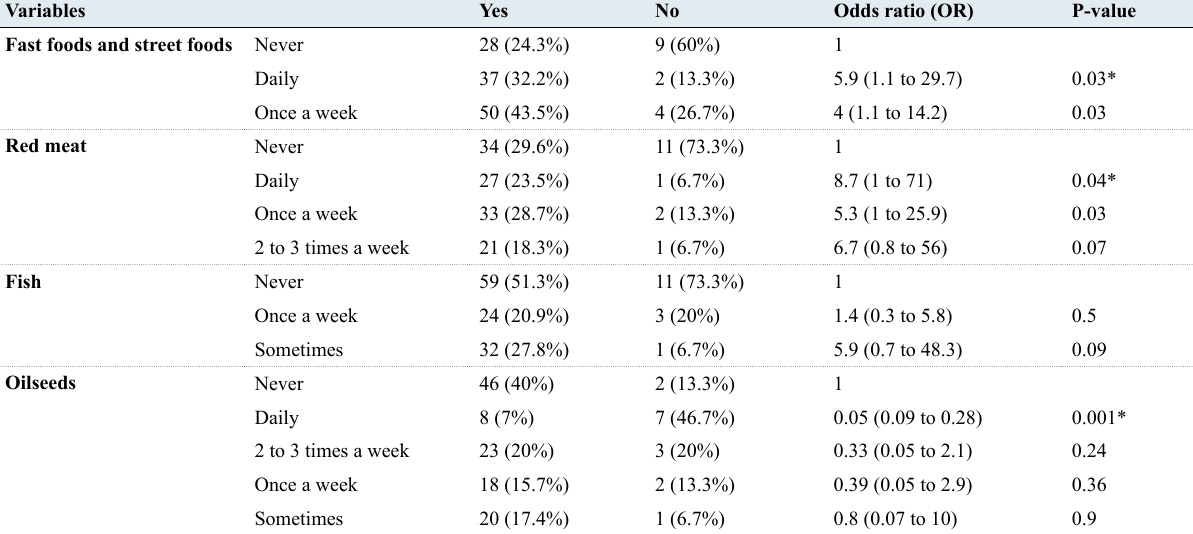
Table 3B: Eating behavior and its association with dyslipidemia in T2DM Variables Yes Fast foods and street foods